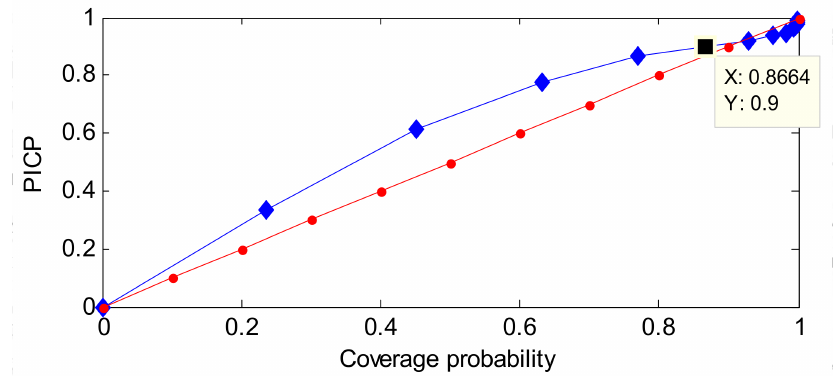
Figure 6. One example of receiver operating characteristic of PI (ROC-PI) based on the relevance vector machine (RVM) method. PICP: PI coverage